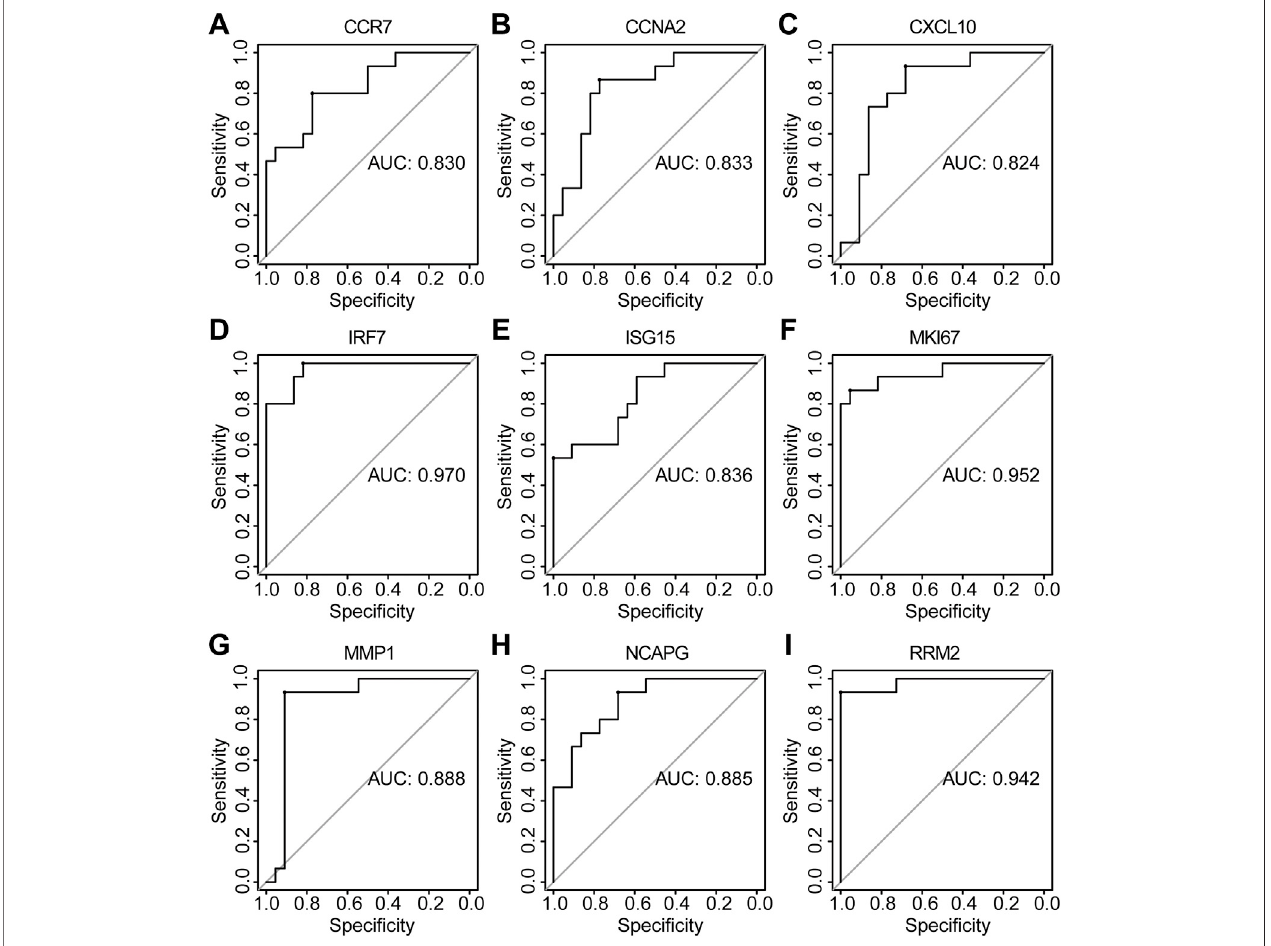
FIGURE 7 | The diagnostic effectiveness of nine hub genes ( (A) CCR7, (B) CCNA2, (C) CXCL10, (D) IRF7, (E) ISG15, (F) MKI67, (G) MMP1, (H) NCAPG, and (I) RRM2 was validated using GSE120721.